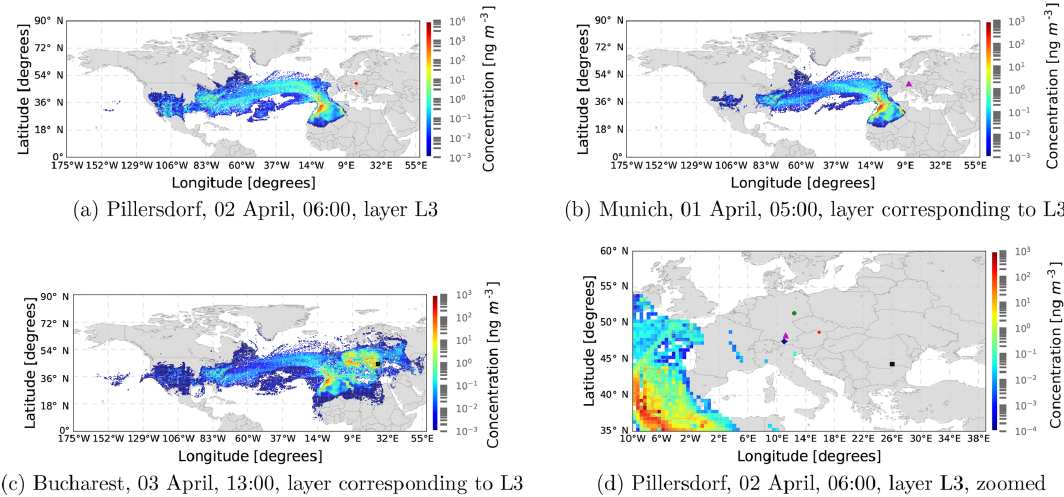
Figure 12. Relative distributions of SO 2 sources for Pillersdorf layer L3 (a) , Munich (b) , and Bucharest (c) ; zoomed distribution for Pillers- dorf layer L3 (d) .